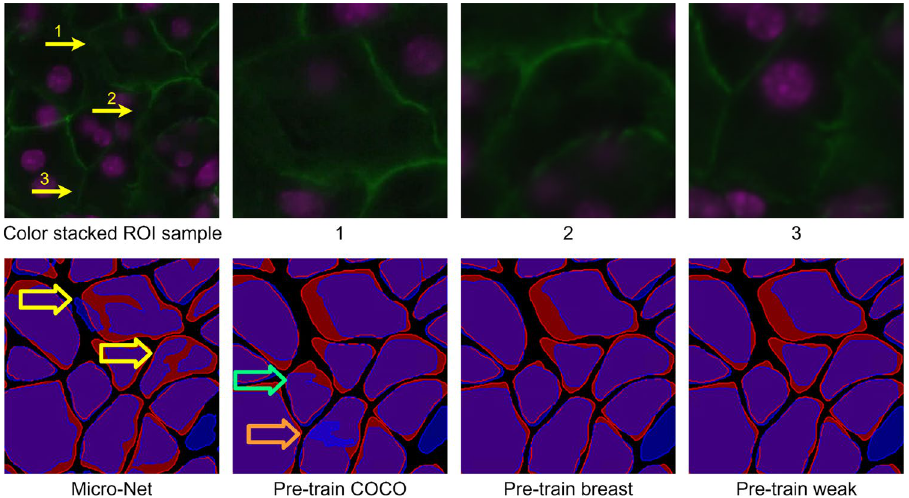
Figure 7. Visual results for an example of a mouse pancreatic tissue sample. The first row shows the color stacked image from DAPI and E-cadherin (Ecad) stained images 1, 2 and 3 are regions highlighted by the yellow arrows. Those regions are in a zoomed-in view at the right. The second row shows the results using different methods. Red: contour mask generated from manual annotation. Blue: contour mask generated from system outputs. Purple: overlapped region of manual annotations and system outputs. This figure is created using diagrams.net (https:// www. diagr ams.